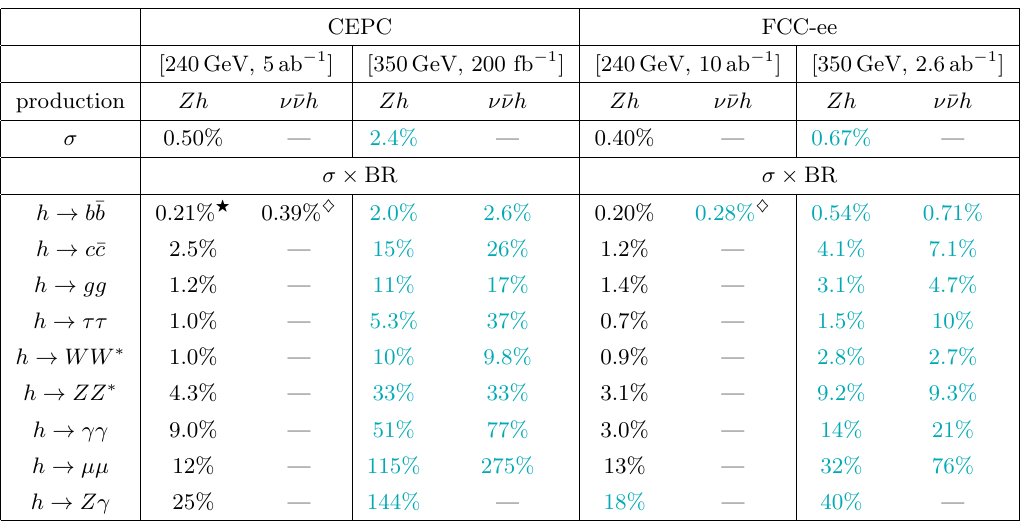
Table 2 . The estimated precision of CEPC and FCC-ee Higgs measurements. We gather the available estimations from refs. [1, 2, 86], while the missing ones (highlighted in green) are obtained from scaling with luminosity. See appendix B for more details. For (cid:27) ( e + e (cid:22) (cid:23)h ), the precisions (cid:0) ! (cid:23) marked with a diamond are normalized to the cross section of the inclusive channel which includes } both the WW fusion and e + e (cid:22) (cid:23) , while the unmarked precisions are normalized to (cid:0) ! hZ; Z ! (cid:23) the WW fusion process only. For the CEPC, the precision of the (cid:27) ( hZ ) BR( h b (cid:22) b ) measurement (cid:2) ! (marked by a star F ) reduces to 0.24% if one excludes the contribution from e + e (cid:0) ! hZ; Z ! (cid:23) (cid:22) (cid:23); h b (cid:22) b to avoid double counting with e + e (cid:0) (cid:23) (cid:22) (cid:23)h; h b (cid:22) b . The corresponding information is ! ! ! not available for the FCC-ee.